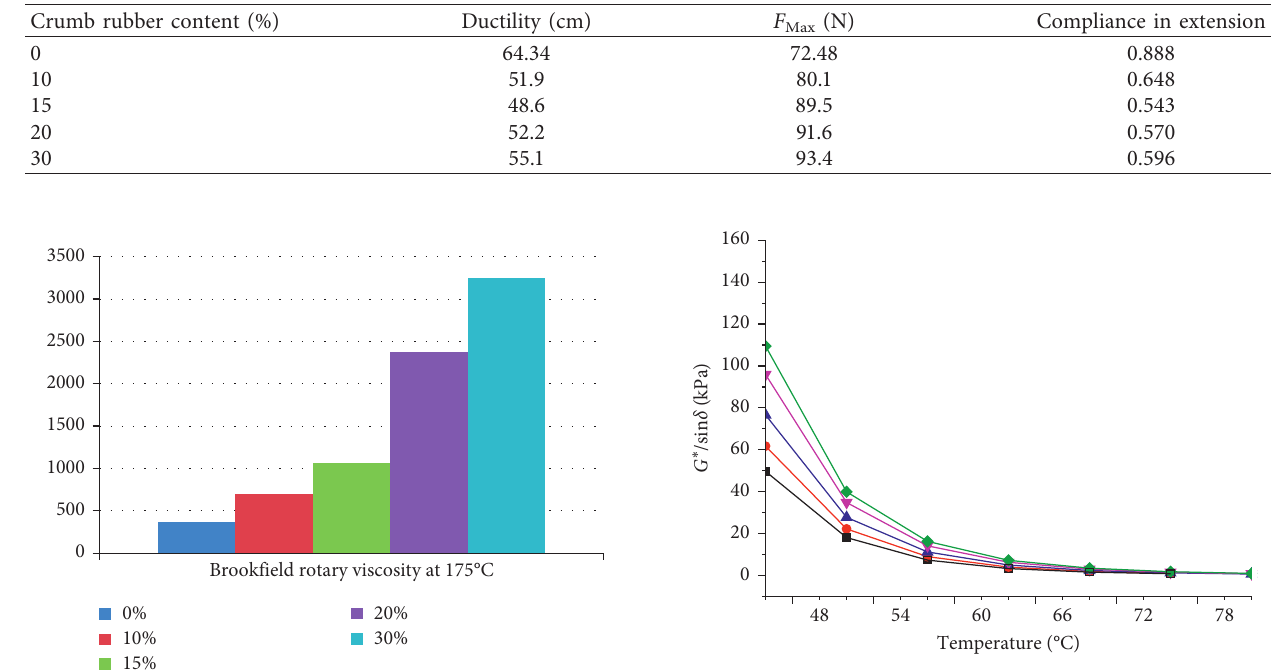
Table 4: Force ductility test result of crumb rubber-modified asphalt at 5 ° C.